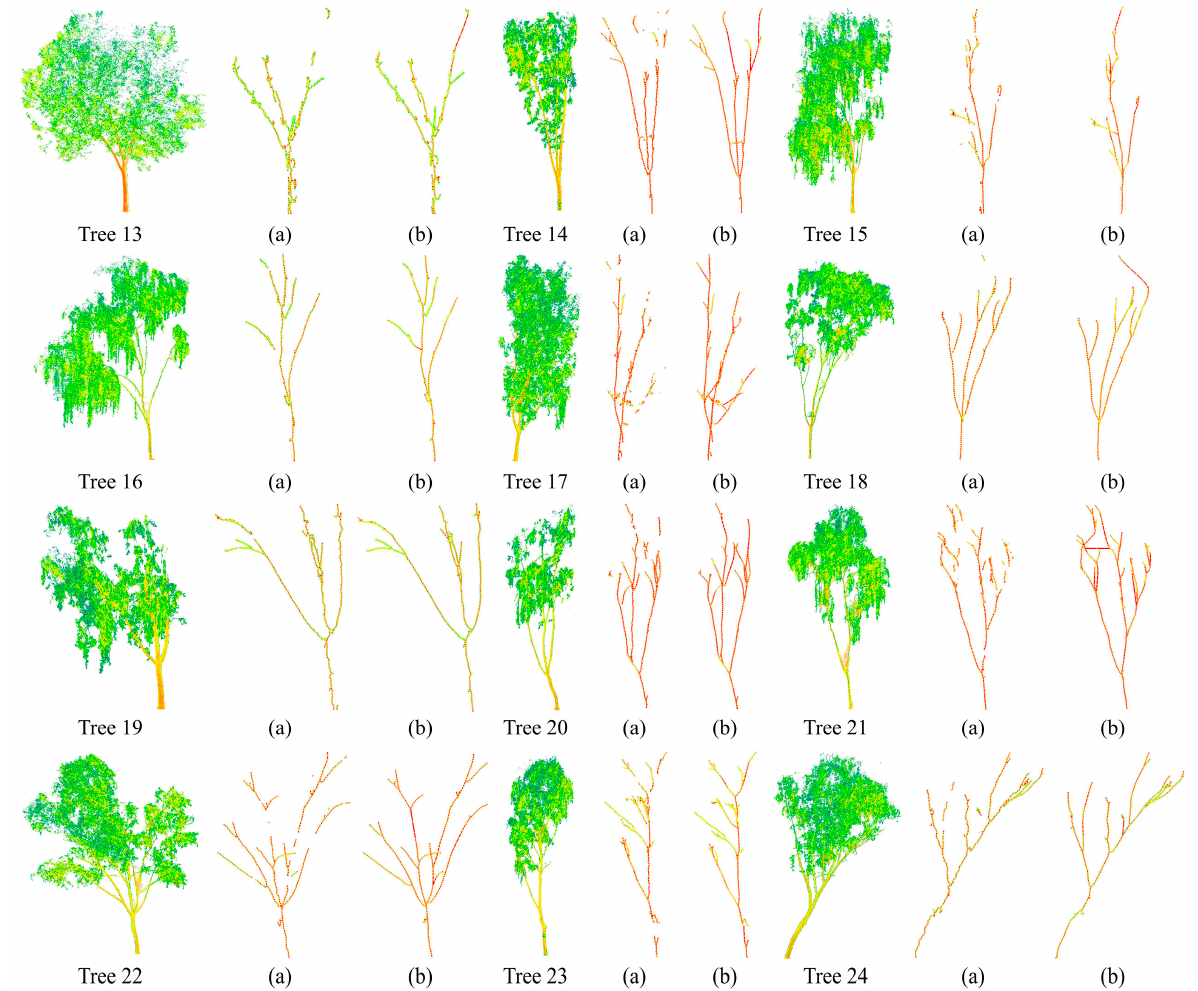
Figure 6. The tree skeleton results of 24 willow trees using the proposed method. (a) The skeleton before breakpoint connection, (b) the final skeleton.